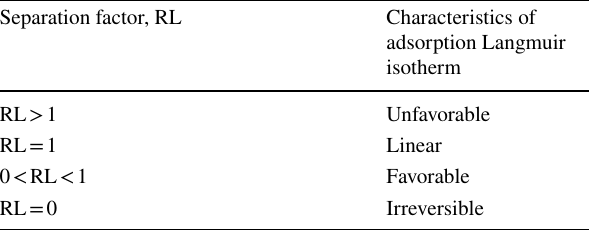
Table 3 Characteristics of adsorption Langmuir isotherm Separation factor, RL Characteristics of adsorption Langmuir